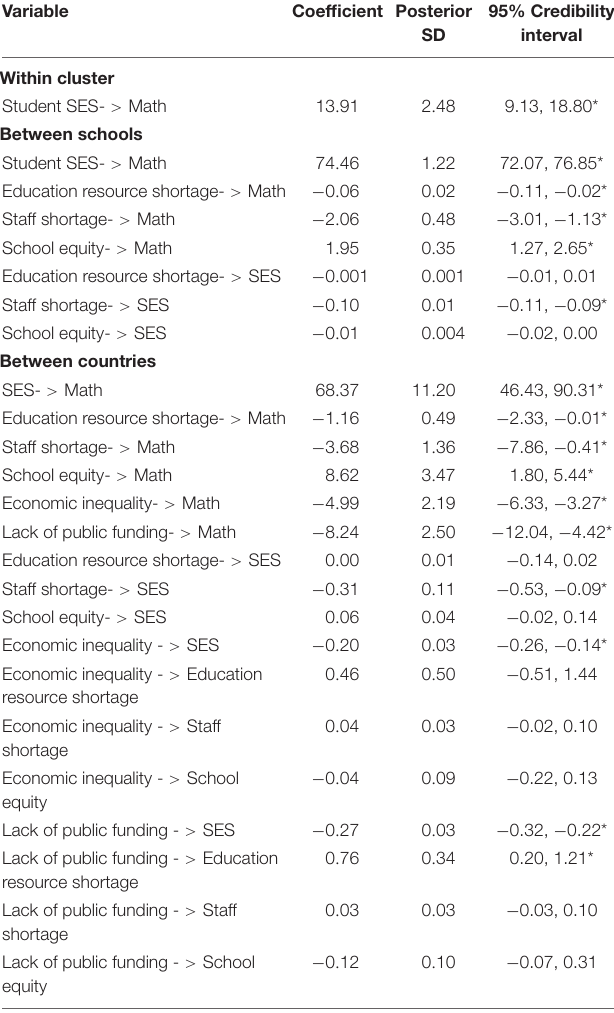
TABLE 3 | Variance estimates, posterior standard deviations, 95% credibility intervals, and ICC/PCV values for null model and partial mediation models.